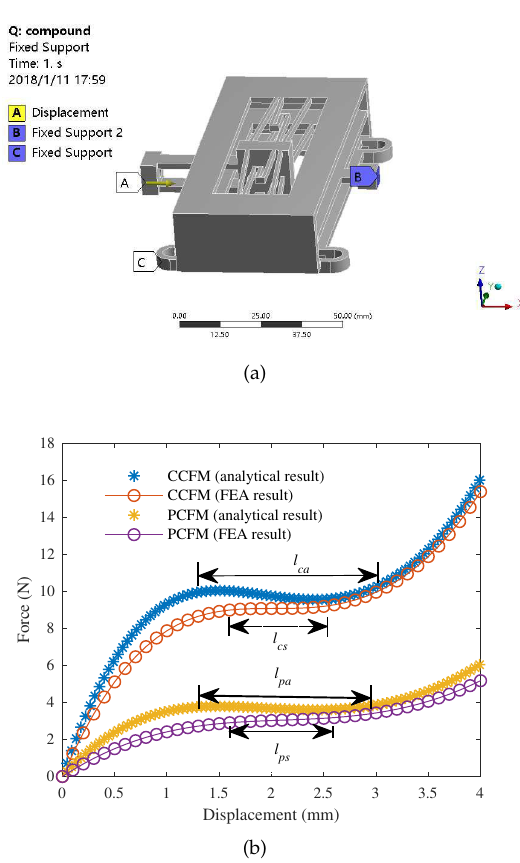
Figure 5. FEA simulation results. ( a ) Simulation setup; ( b ) Comparison between simulation and analytical model